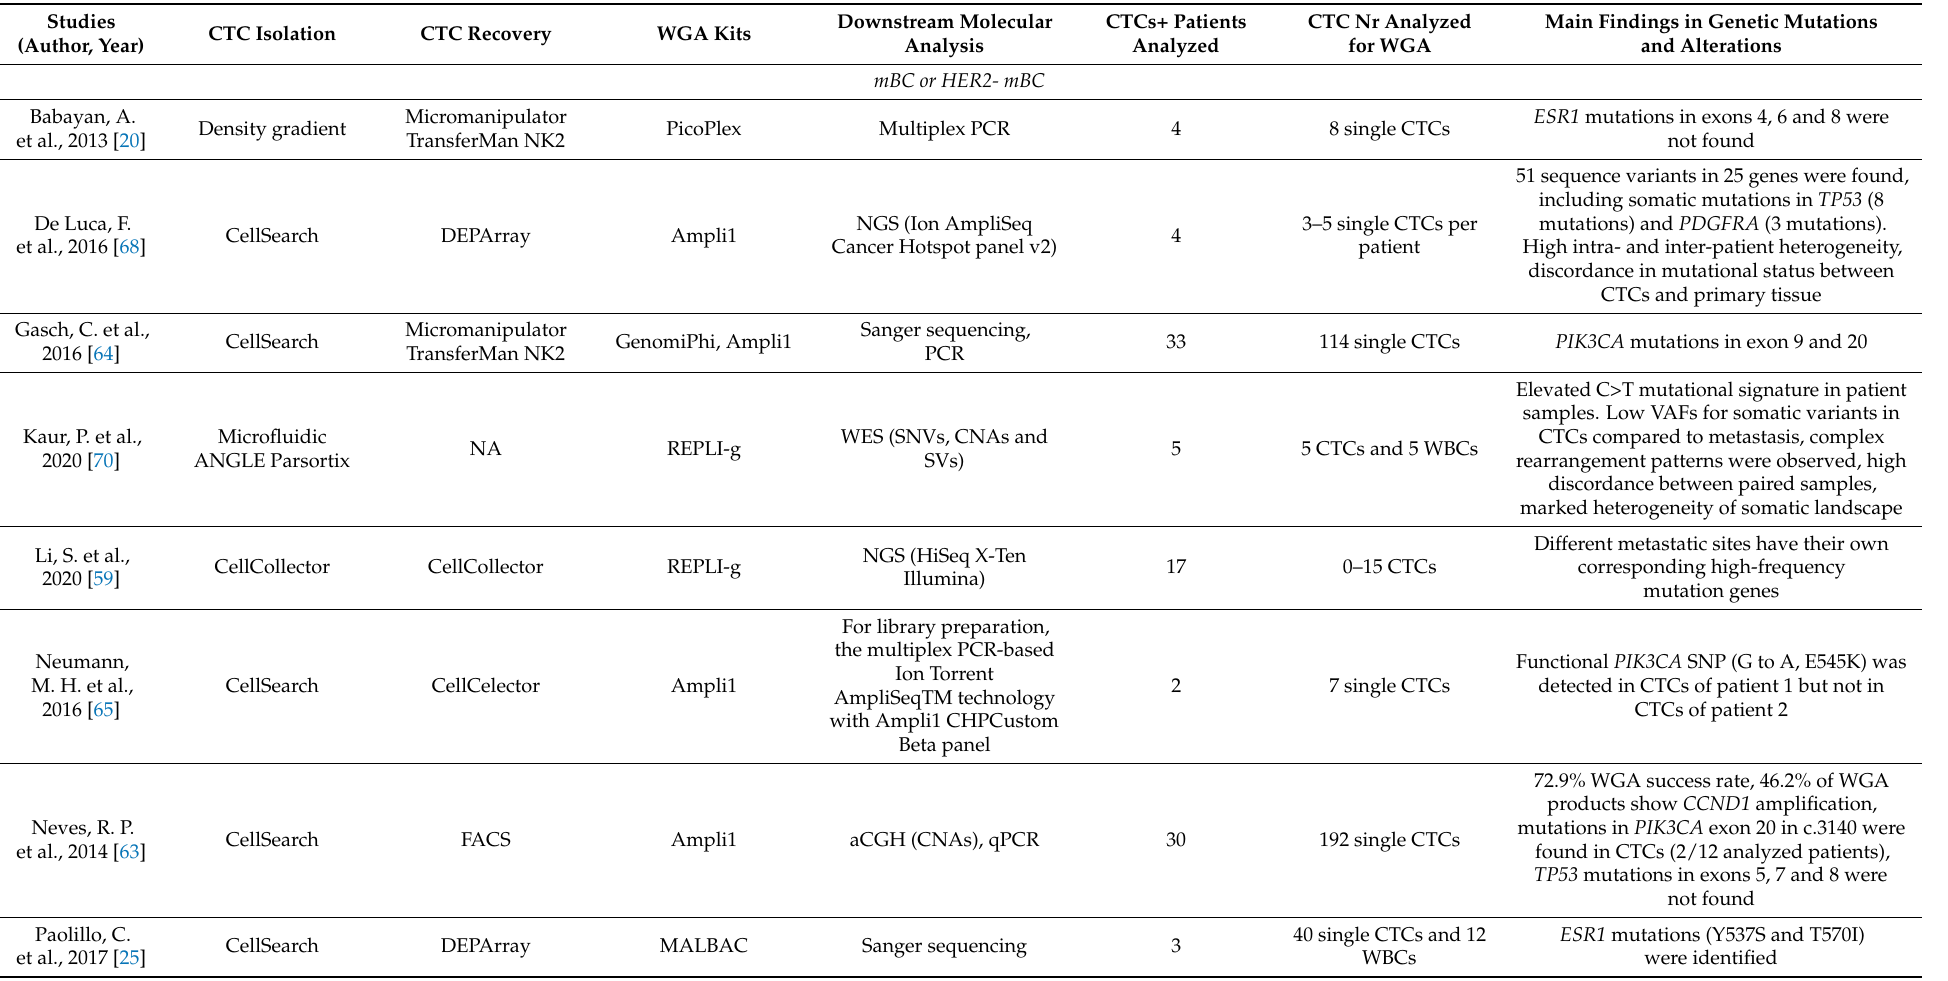
Table 2. The application of WGA and biomarker detection of single CTCs in various cancer